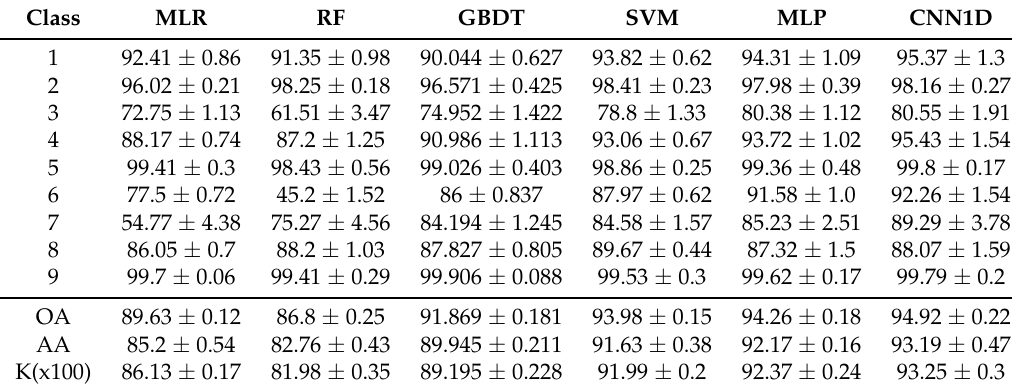
Table 6. UP data set results.